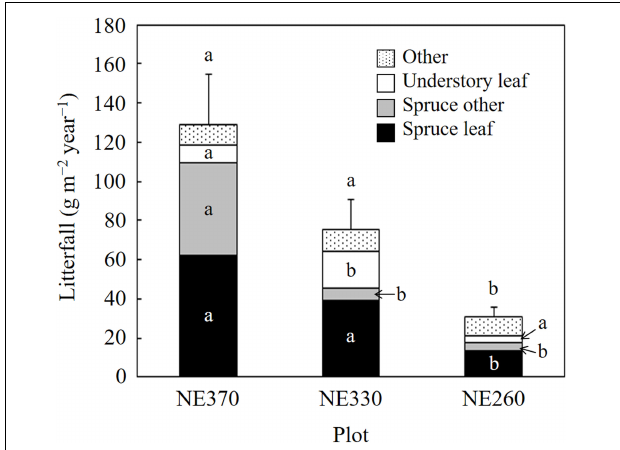
FIGURE 2 | Fine root mass of black spruce and understory plants in NE360, NE330, and NE260 plots. White and gray columns represent data on roots < 0.5 and 0.5–2.0 mm in diameter. Data shown are mean + SE ( N = 9). Different alphabetical letters indicate significant difference between the plots for total fine root mass in < 2 mm in diameter (a–b, Tukey–Kramer HSD test; x–y, Steel–Dwass